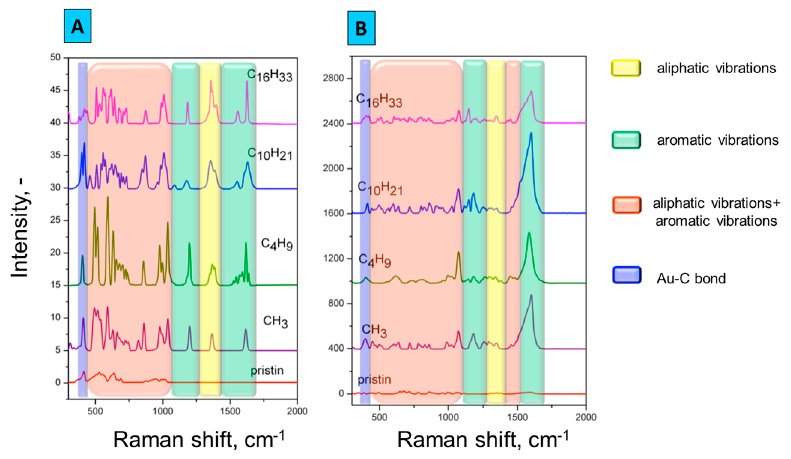
Figure 2. Raman spectra of gold gratings grafted by ADTs via spontaneous and electrochemical approaches.